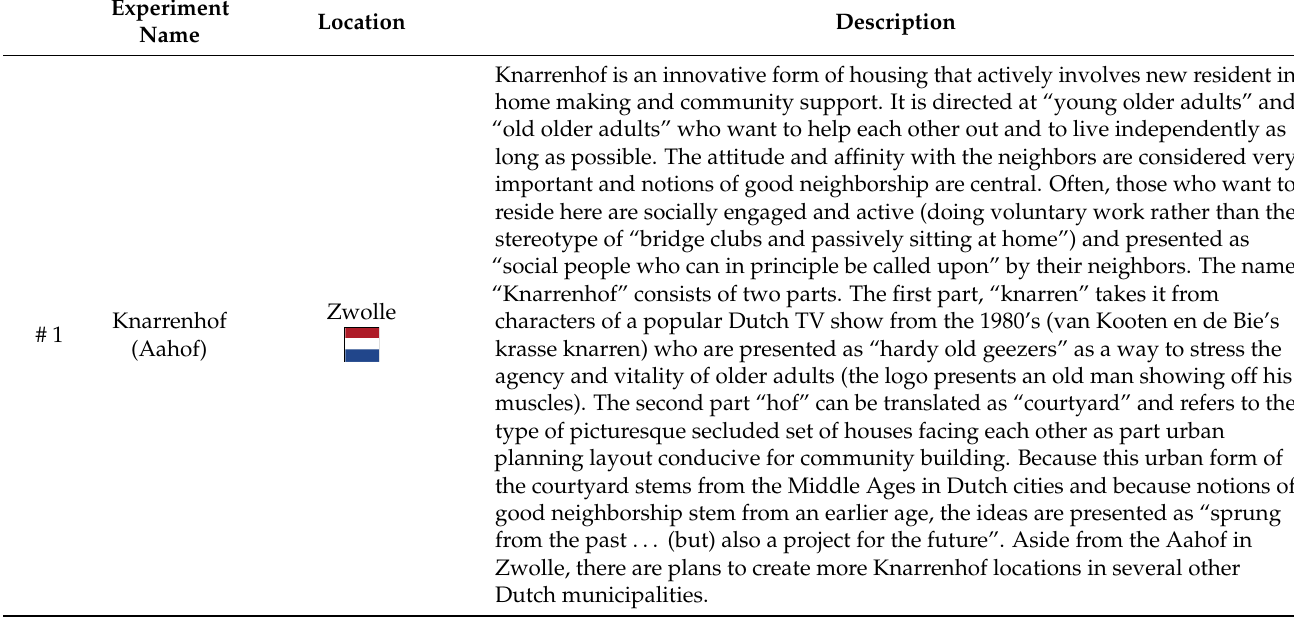
Table 2. Overview of 8 key age-friendly home experiments in the Netherlands, France, Ireland and Poland (see Table A1 Table A1. Full overview of 53 age-friendly home experiments in the Netherlands, France, Ireland and Poland. in Appendix A for the complete overview of 53 Experiment